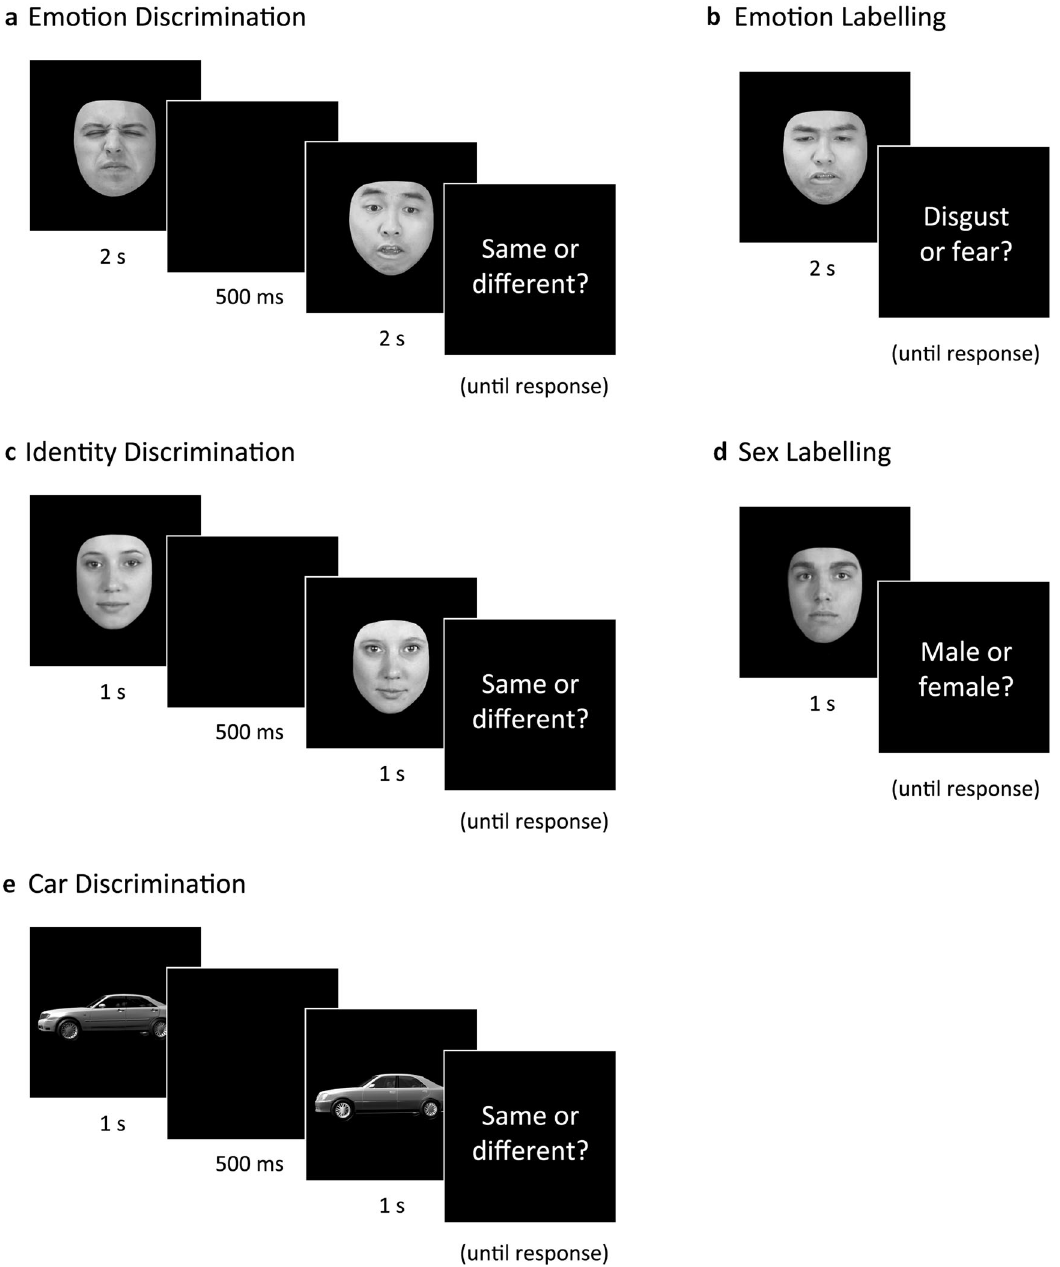
Fig. 1 Example trials for each task illustrate a snapshot image of the dynamic video stimulus presented to participants. Participants were asked to report whether the feature of interest was the same or different across the two videos ( a , c , and e ) or to label the emotion illustrated as disgust/fear ( b ) or the sex was male/female ( d ). Morphing of the video fi les was used to create different levels of task dif fi culty. Further details regarding the stimuli set and morphing procedure are provided in supplemental Figures 1 – 3 and the methods paper by Darke and colleagues 52